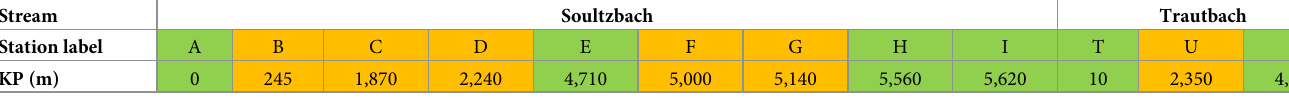
Table 2. Location of temperature monitoring stations on each stream. Stream